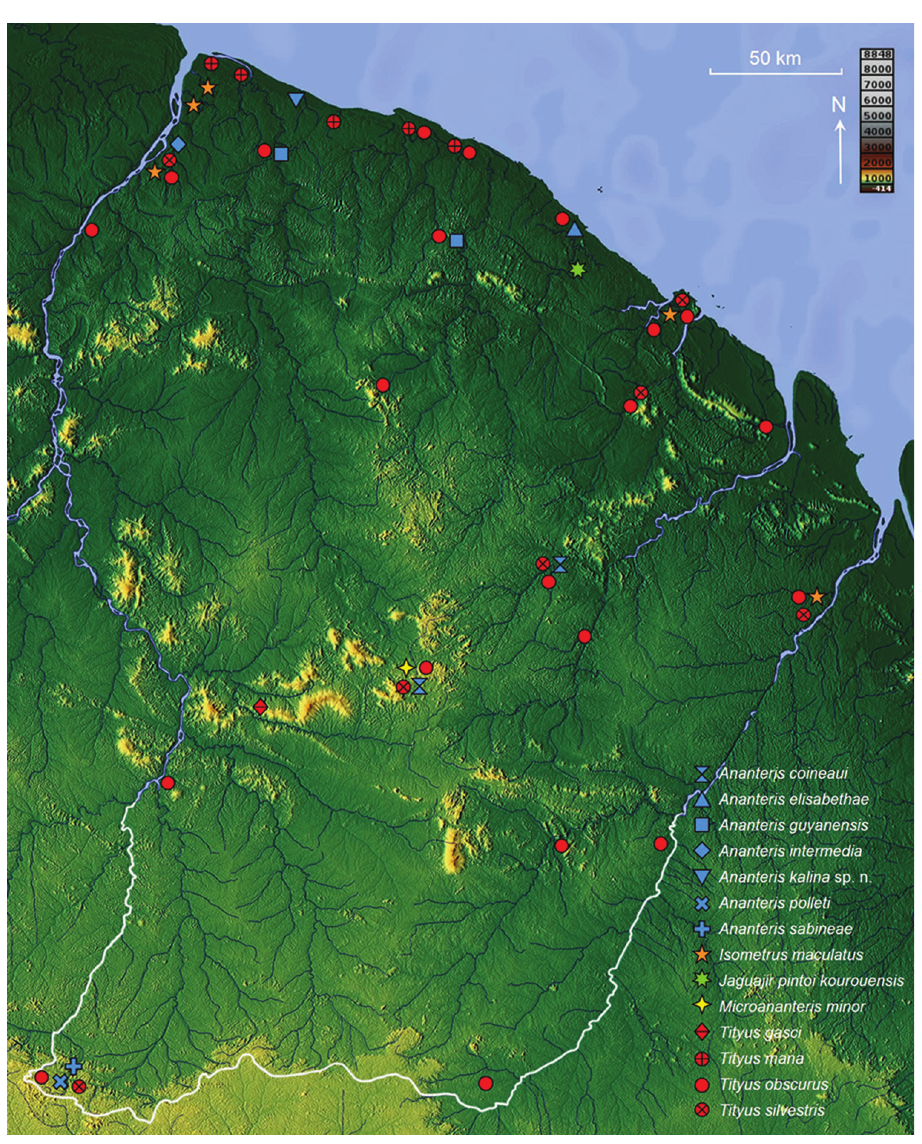
Figure 31. Topographic map of French Guiana showing the distribution of species of the family